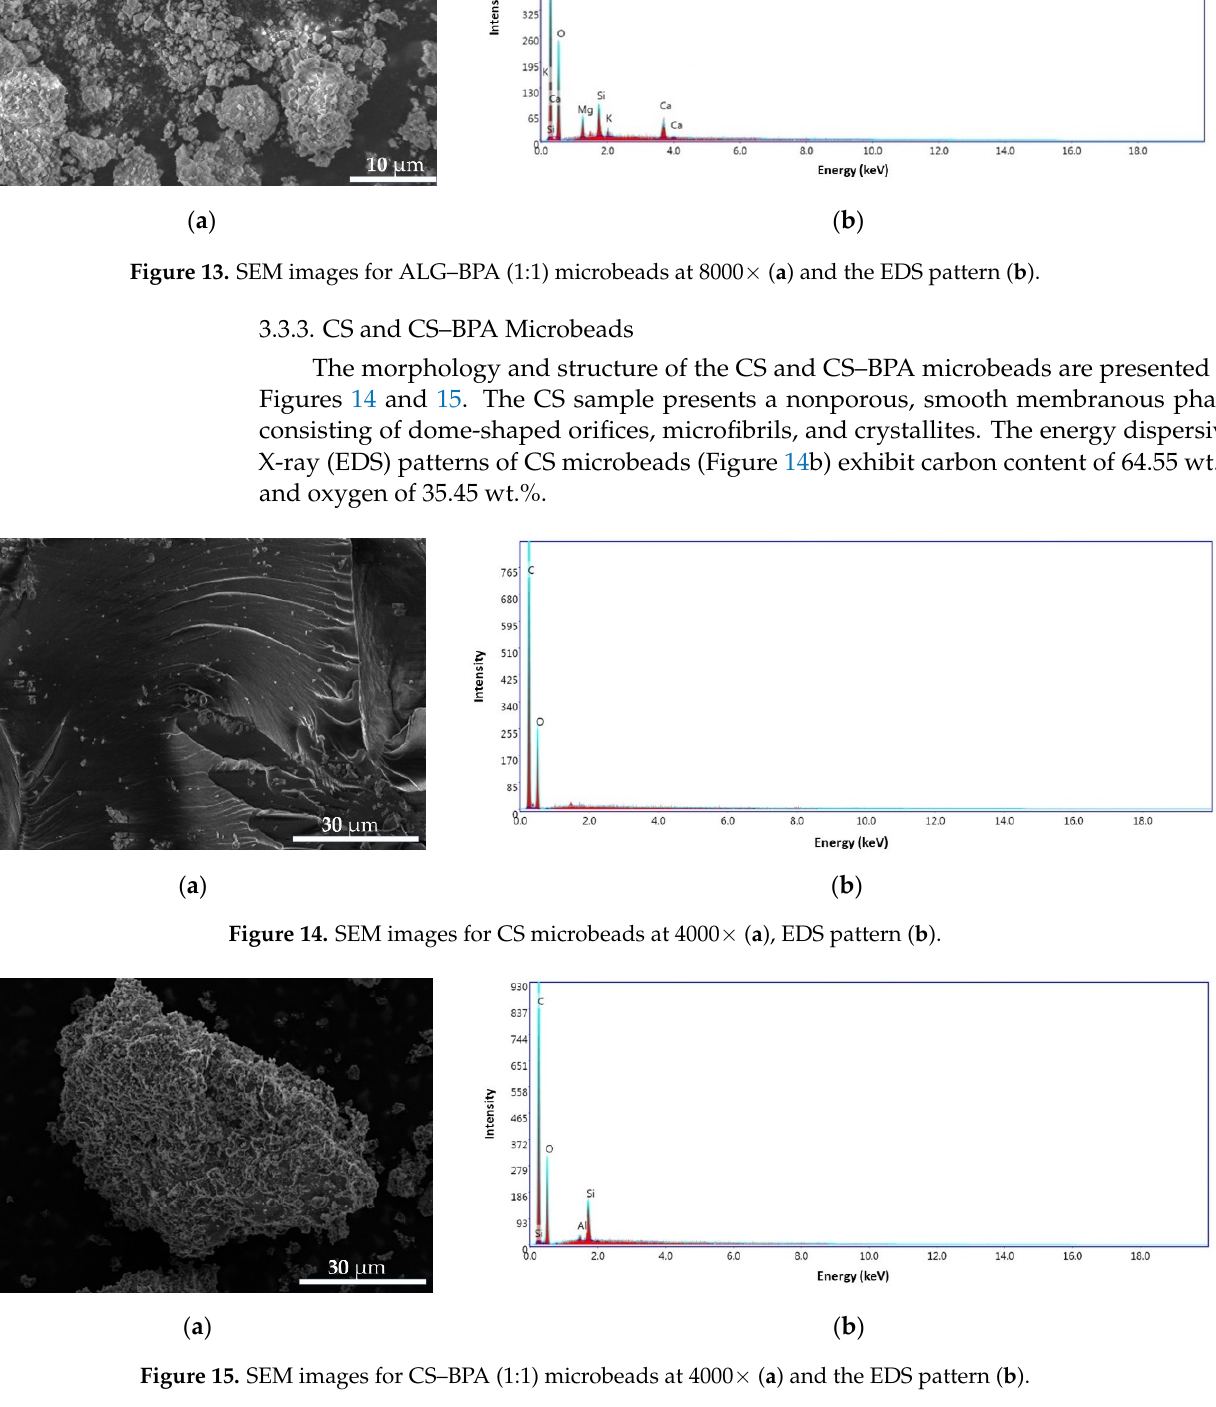
( b ) Figure 16. Qualitative analysis on a multielement solution (concentration 0.5 mg/L) for BPA ( a ) and removal efficiency ( b ). It can be observed from Figure 16b that the removal efficiency is high for all the met- als studied, reaching 100% for Zn after only 30 min of contact and for Cd and Fe after 60 min of contact. For all metals studied, the removal efficiency was over 97% after 30 min of contact. Similar results for different metal ions were obtained by other researchers when using wood ash. In a study by Mosoarca et al. [37], ash obtained from wood-burning was used to retain Mn 2+ ions from wastewater. They found that the material presents an ad- sorption efficiency of over 90% but can be increased to over 98% by parameter control, with best values obtained for pH~6, a material dose of 10 g/L. Wood ash was also studied by Pehlivan et al. [38] for the removal of Cr 4+ ions. They observed that the adsorption of Cr 4+ ions was higher at a pH between 2 and 2.5. Borlodoi et al. studied how ash obtained from banana peels can remove iron ions from groundwater from a concentration of 20 mg/L to 0.3 mg/L [39]. Das et al. [40] obtained ashes from bamboo, banana leaf, banana rind, banana pseudo-stem, and rice husk, tested them for the removal of Fe 2+ ions from water samples and found the most efficient to be the banana pseudo-stem ash. Due to the small particle size that provides a high surface area and thus a maximum efficiency in removing metals, the regeneration process is difficult. Thus, after testing in multielement solution, for 60 min, the BPA material was dried and weighed, and it was observed that the recovery yield of the BPA material is about 25%; the losses thus influ-